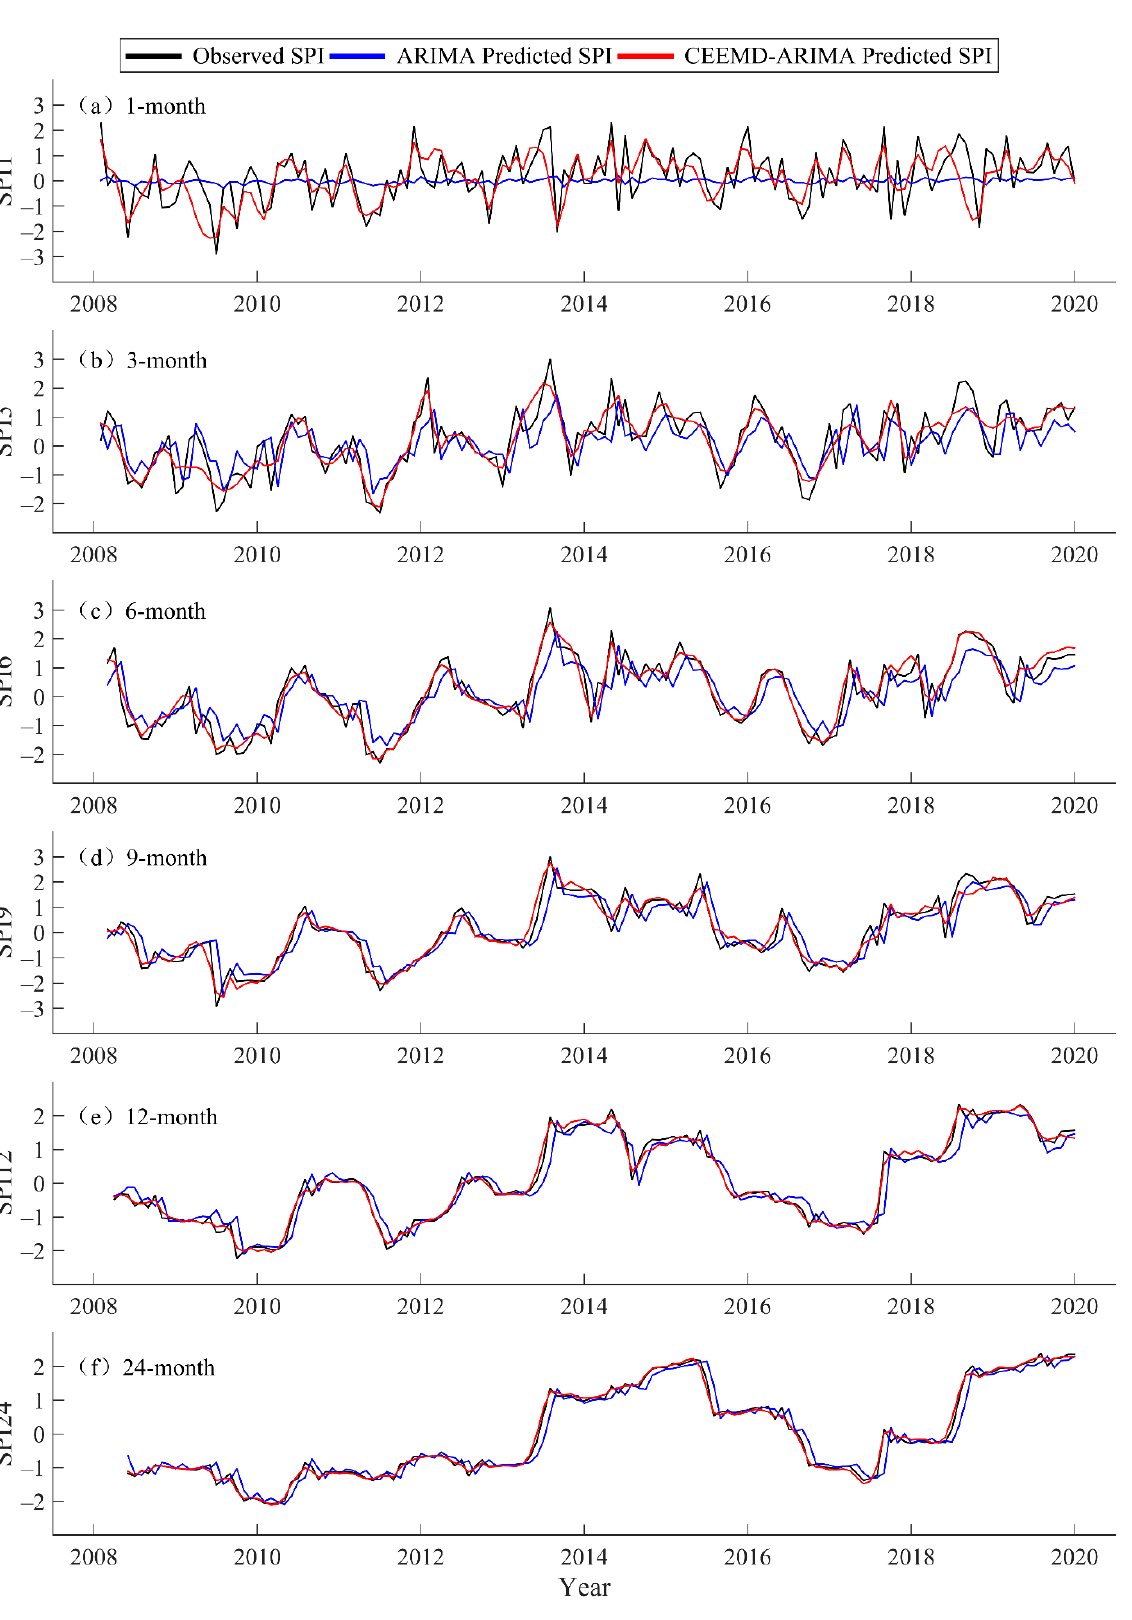
Figure 7. Comparison of the predicted and observed values of the SPIs on the 1-month ( a ), 3-month ( b ), 6-month ( c ), 9-month ( d ), 12-month ( e ), and 24-month ( f ) time scales of the ARIMA model and the CEEMD–ARIMA model at Xiji Station (2008–2019).